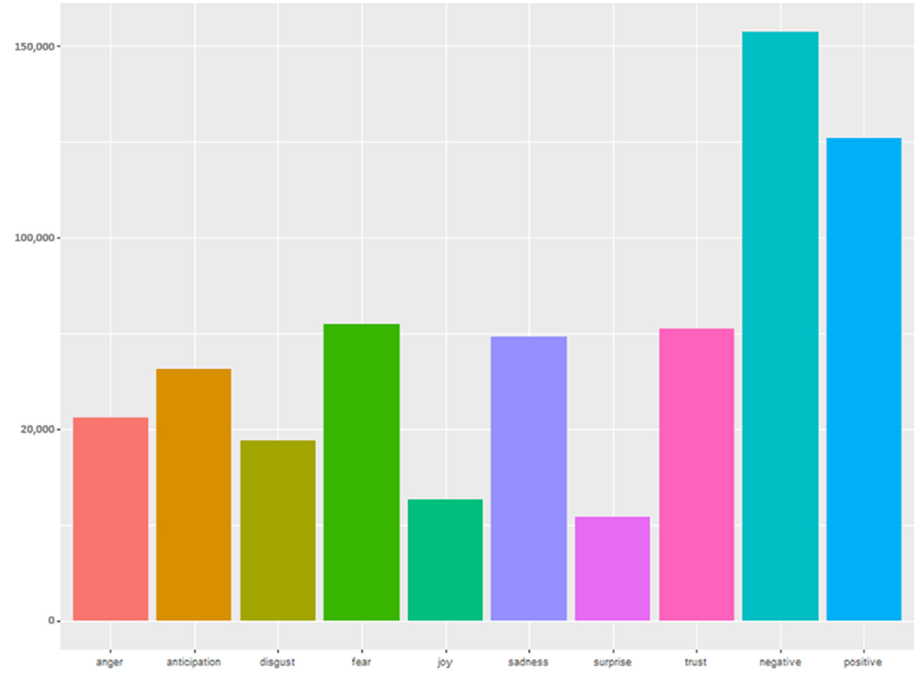
Figure 9. Analysis of sentiments and emotions graph (period 2).